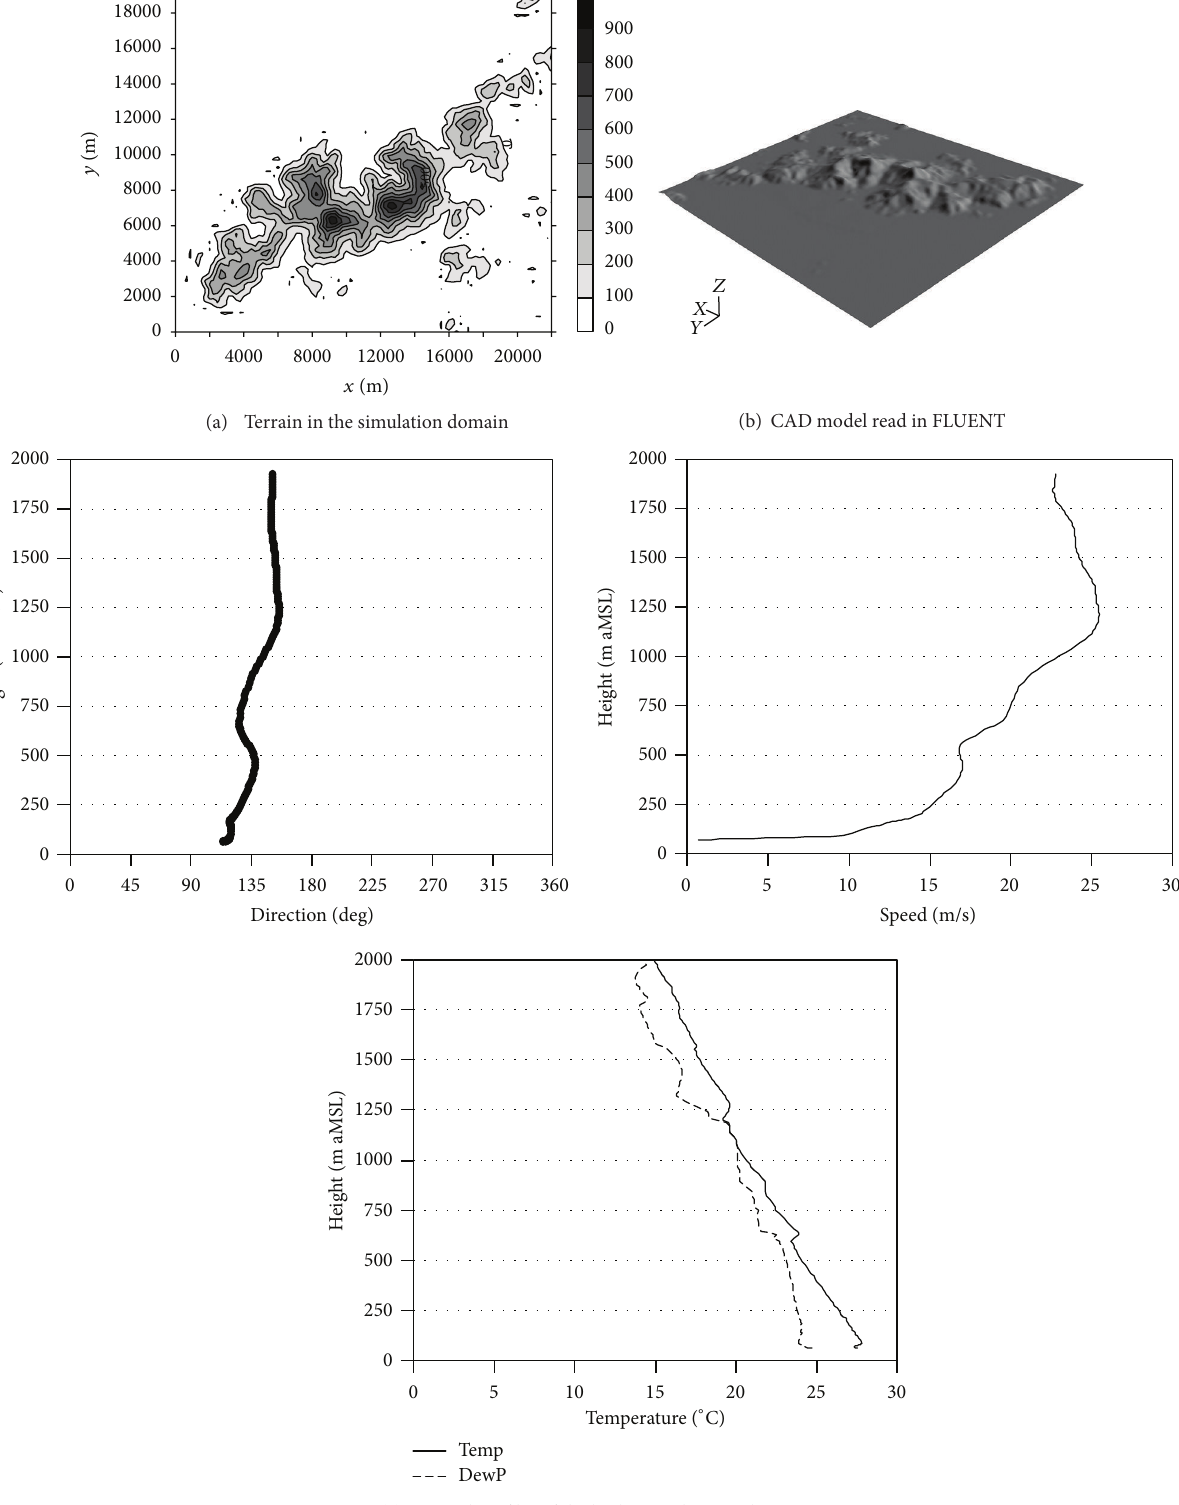
Figure 2: Terrain within FLUENT simulation is shown in (a) and (b). (c) gives the background atmospheric condition for the simulation as obtained from the radiosonde sounding in Hong Kong at 12 UTC, September 29, 2011. The figures include the wind direction profile, wind speed profile, and temperature and humidity